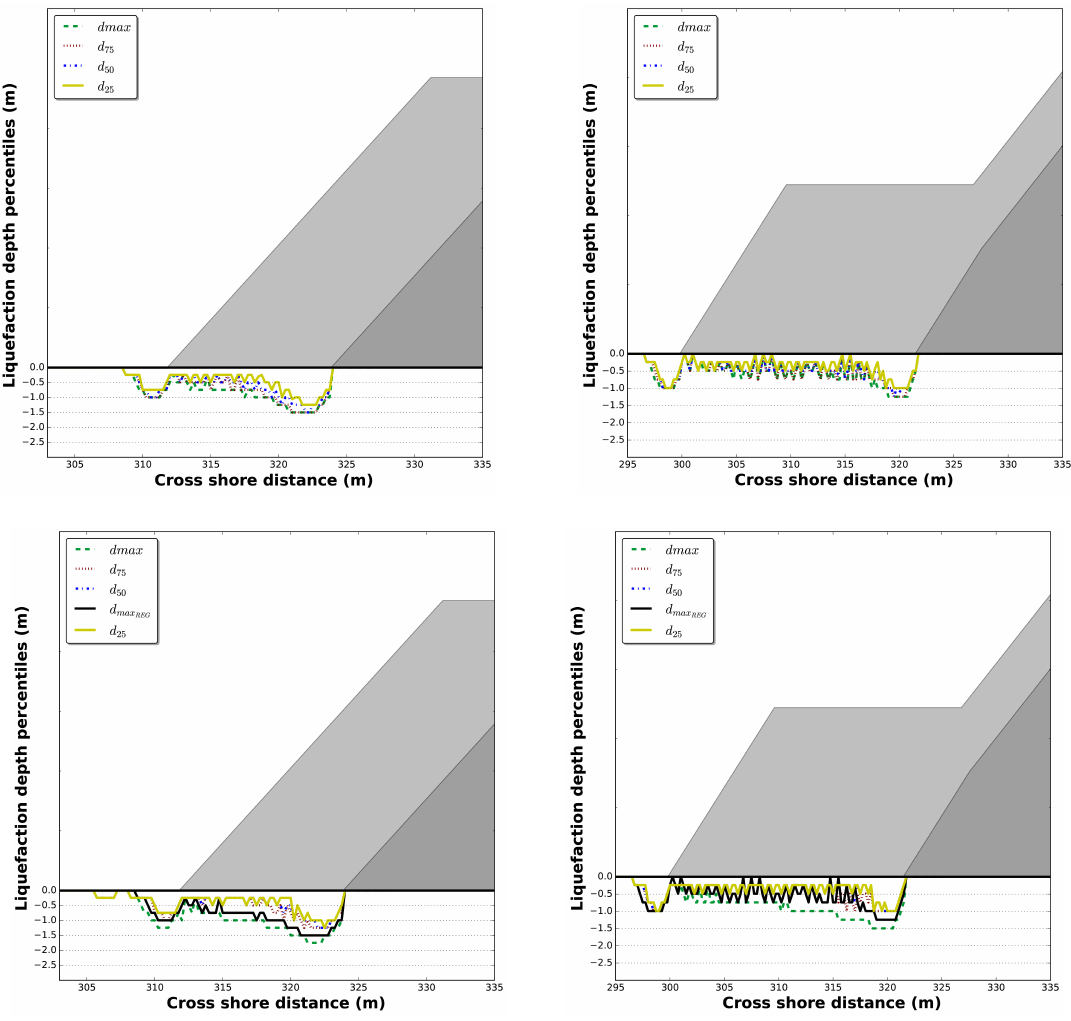
Figure 10. Momentary liquefaction depth percentiles induced by regular and random waves. Left panels refer to submerged berms characterized by h b / h t = 0.19, L b / L w = 0.35. Right panels refer to submerged berms characterized by h b / h t = 0.59, L b / L w = 0.35. Upper panels refer to momentary liquefaction induced by regular waves. Lower panels refer to momentary liquefaction induced by random